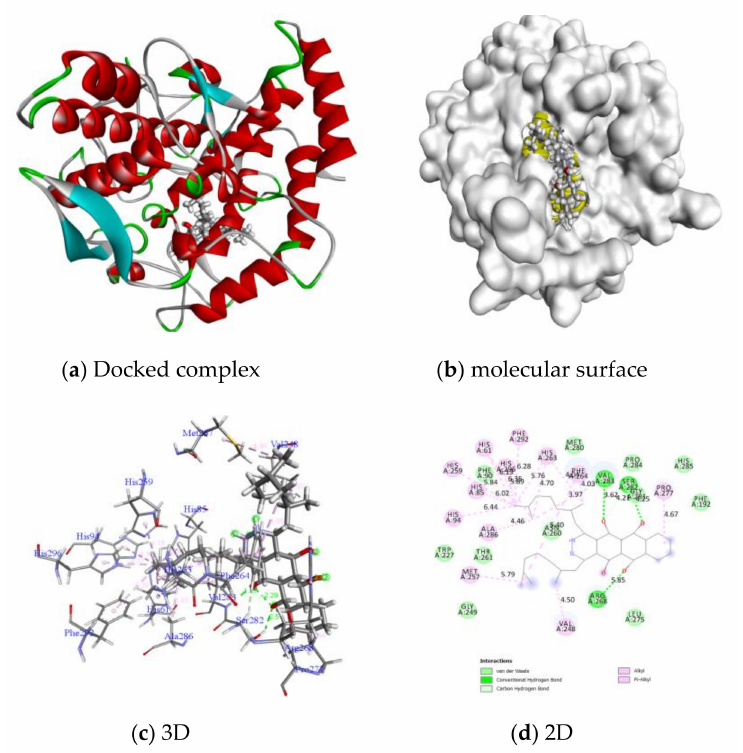
Figure 7. Molecular docking of compound 1c with binding site of 2Y9X protein.